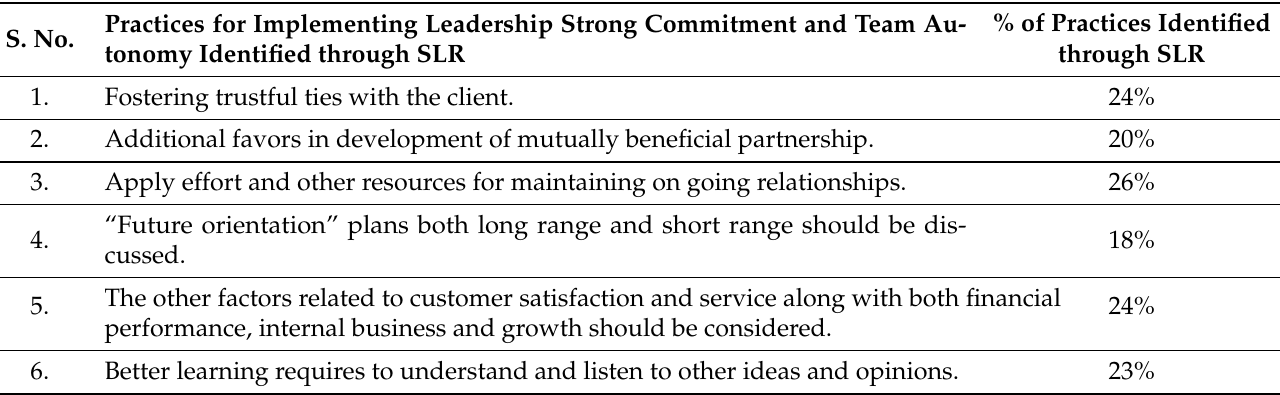
Table 20. Practices for implementing leadership strong commitment and team